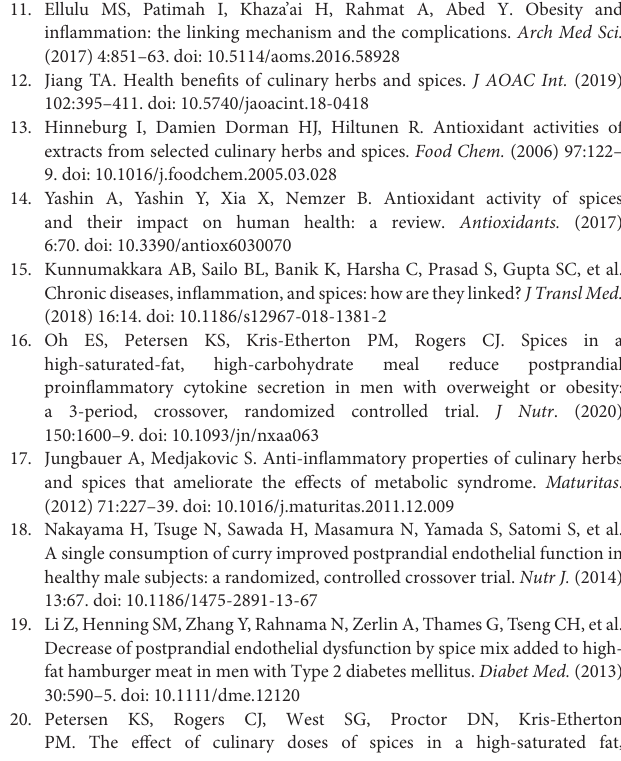
Supplementary Figure 1 | Postprandial flow-mediated dilation (FMD) over 7h after consuming high-fat and high carbohydrate (HFHC) challenge test meals with and without addition herbs and spices (H/S) followed by fasting 24h FMD ( n = 25). Main effect of meal ( P = 0.26), time ( P = 0.17), age (P = 0.02), and significant meal by time interaction ( P = 0.04). Data are means ± standard error of mean, n = 25. %FMD, percentage change in flow-mediated dilation. Data were log-transformed prior to statistical analysis. PROC MIXED (SAS Institute, Inc., Cary, North Carolina) was used for repeated measures and Dunnett-Hsu for post-hoc